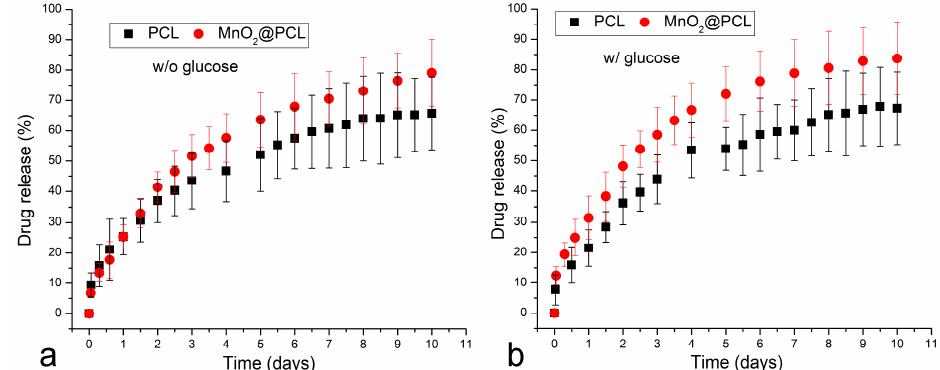
2 @PCL thin films without ( a )